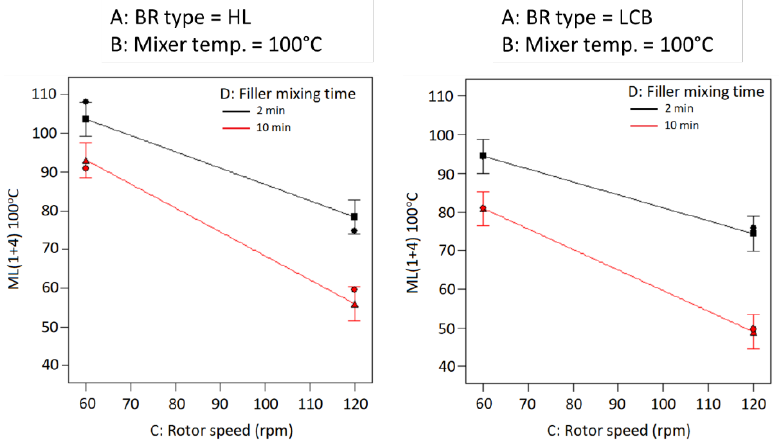
Figure 5 . Interaction plot between the rotor speed and filler mixing time in rubber compounds containing HL-BR and LCB-BR .